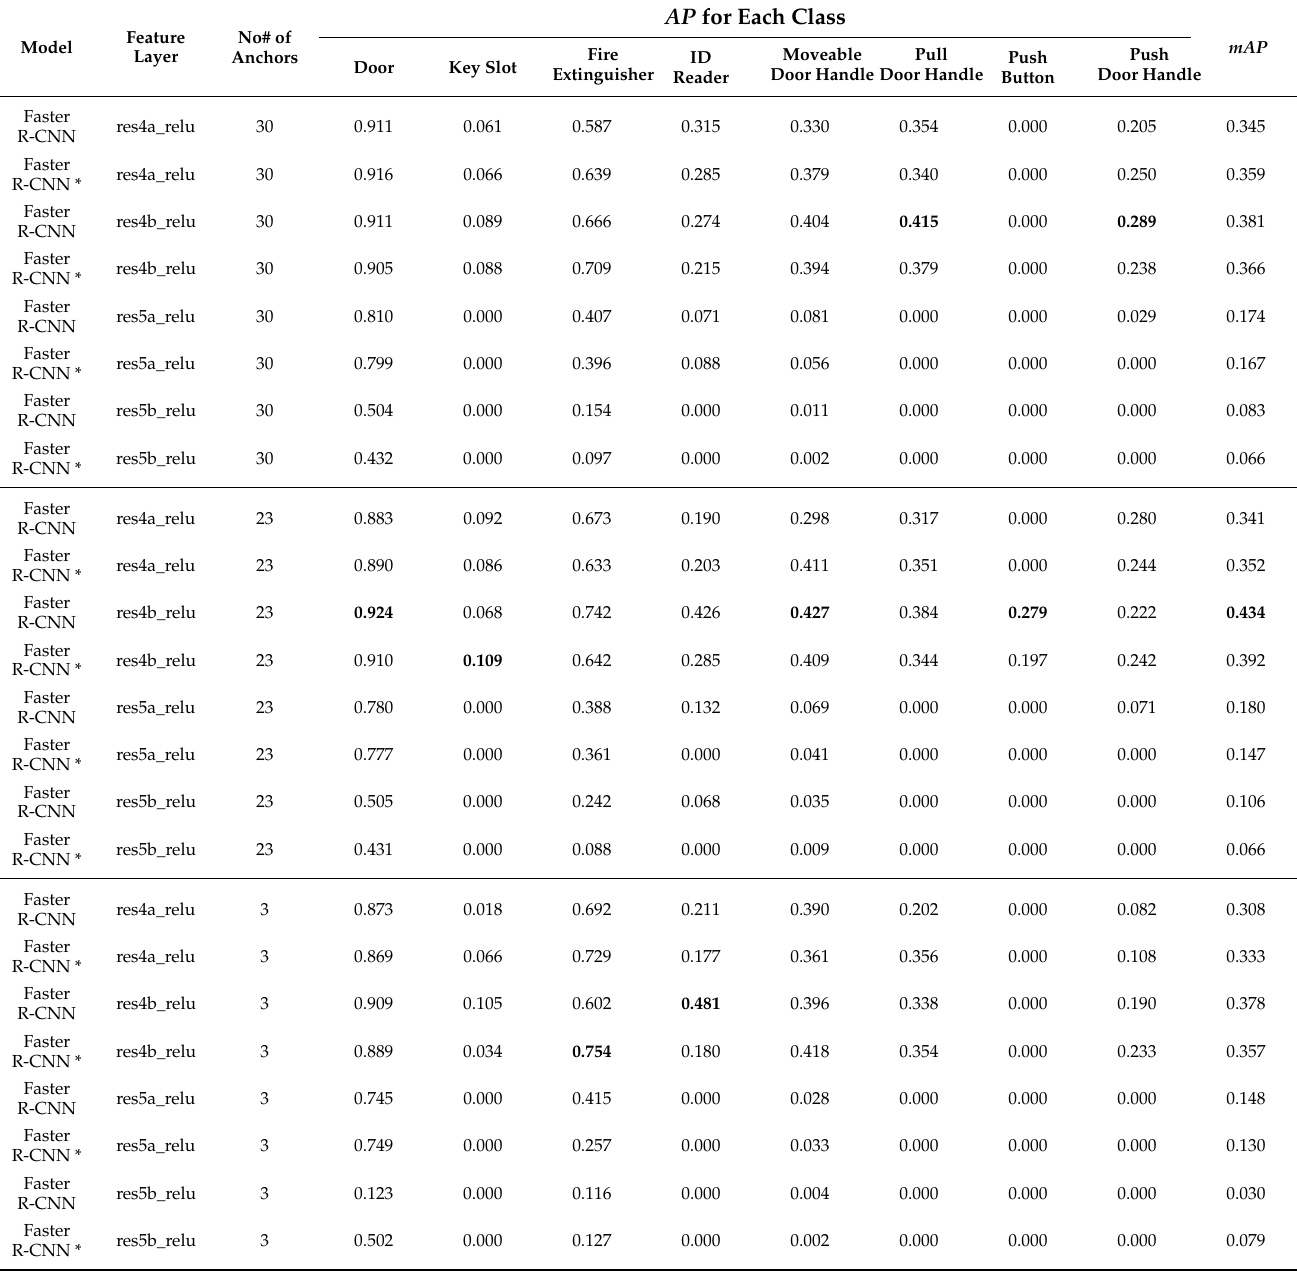
Table 4. Detectors detailed results on the test set (Faster R-CNN with